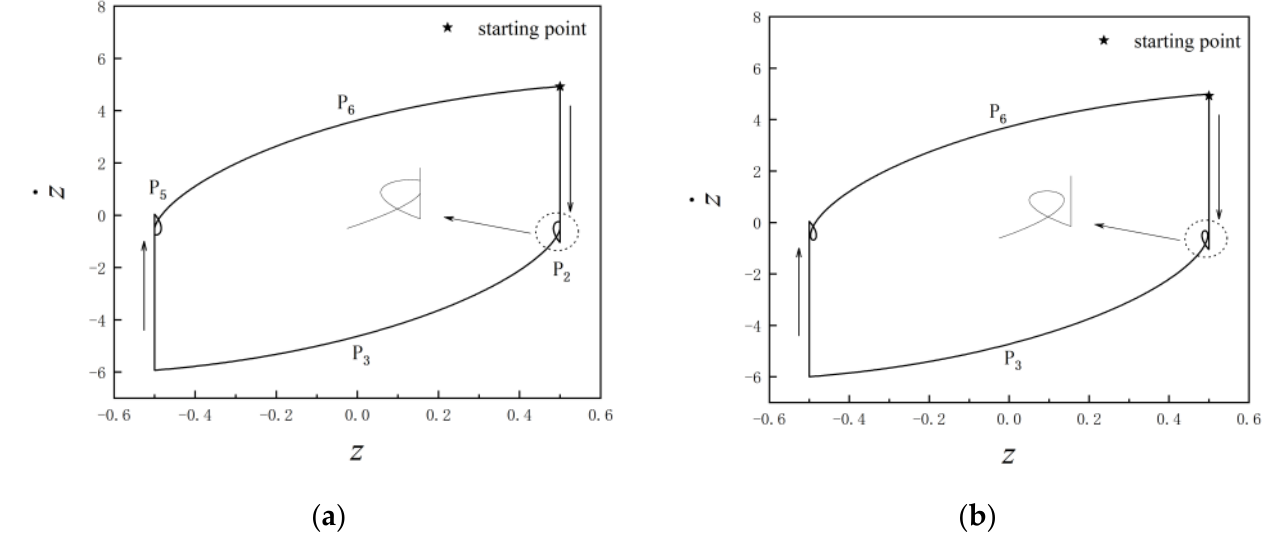
Figure 6. Periodic structure mutation. ( a ) e = 0.0997, ( b ) e = 0.0998. 3.1.2. Chaotic Phenomena Induced by Grazing Bifurcation As shown in Figure 7, the system will enter chaos when e has a small increase after the grazing bifurcation.